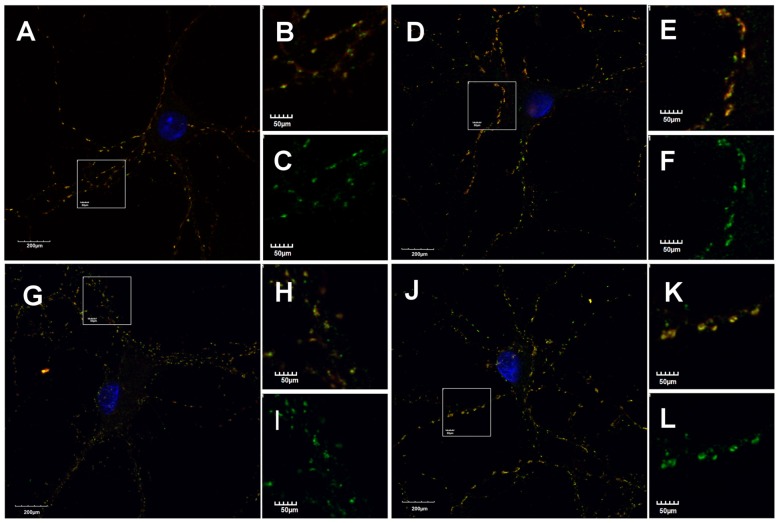
Astrocytes affect morphology of gephyrin stained puncta. Supplementation of NC with astrocytes increase gephyrin (green) puncta size co-stained against vGAT (red) in NC and ANCC stimulated with NMDA. (A–C) Typical staining’s in NC, (D–F) typical staining in NC stimulated with NMDA, (G–I) typical staining in ANCC, (J–L) typical staining in ANCC stimulated with NMDA. Frame squares in (A,G,D,J) indicate the area shown at higher magnification on the right hand side of respective pictures.